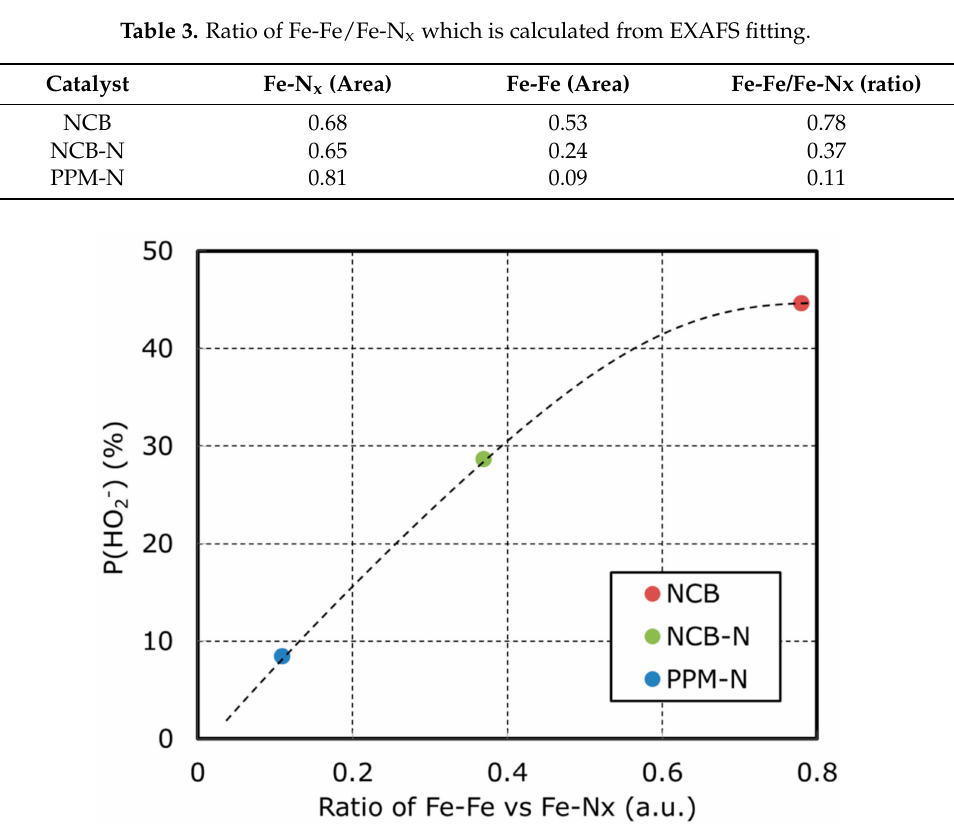
Figure 3. Voltammograms on NCB, NCB-N, and PPM-N of oxygen reduction reaction with rotating ring-disk electrode in 1.0 M KOH at room